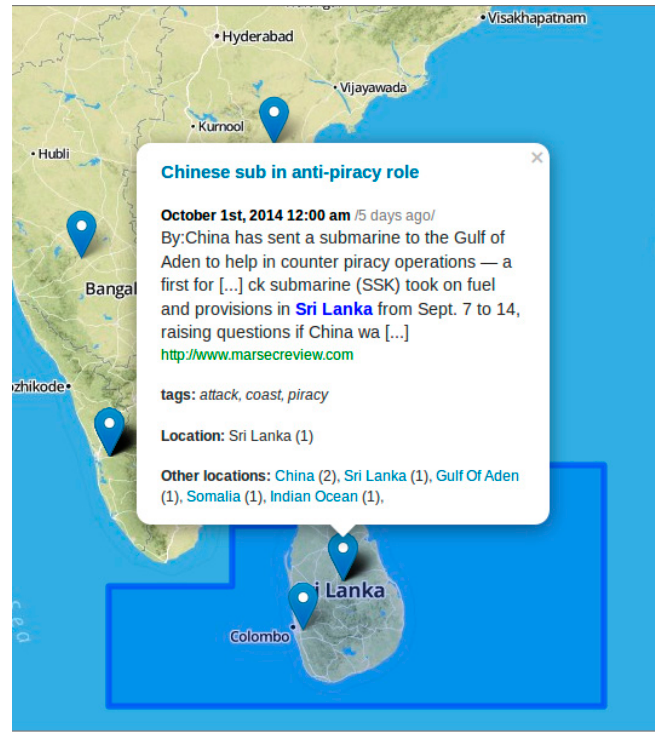
Figure 5. Geo-web interface mapping display. When a user clicks on a point, information regarding the respective document is displayed. Temporal (date and time), thematic (article text and keywords recognized for extraction), and geographic is displayed in a convenient popup window. This window also shows all other geographic locations that were mentioned (recognized and processed) within the article.